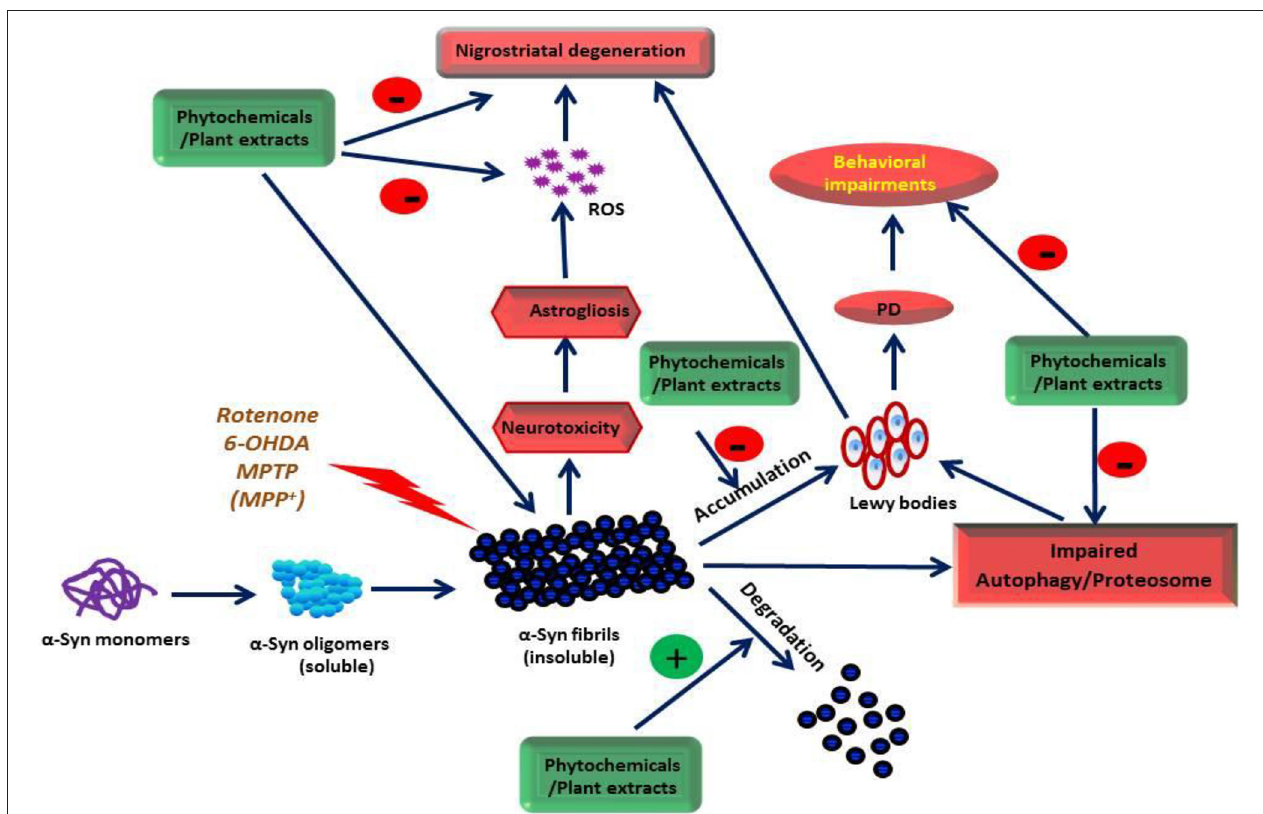
FIGURE 2 | The site of action of the phytochemicals and plant extracts on α